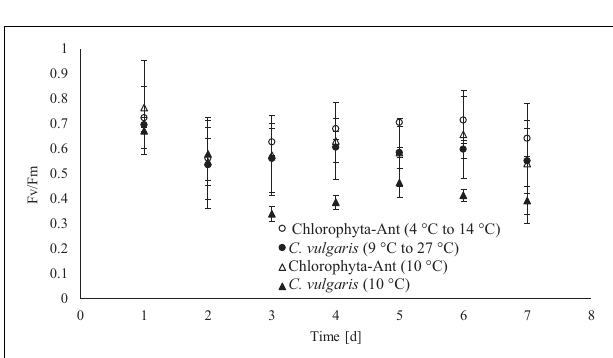
FIGURE 6 | Daily maximum chlorophyll fluorescence for each tested temperature condition, measured after allowing cultures to come to a steady state temperature (19 ◦ C for C . vulgaris , 10 ◦ C for